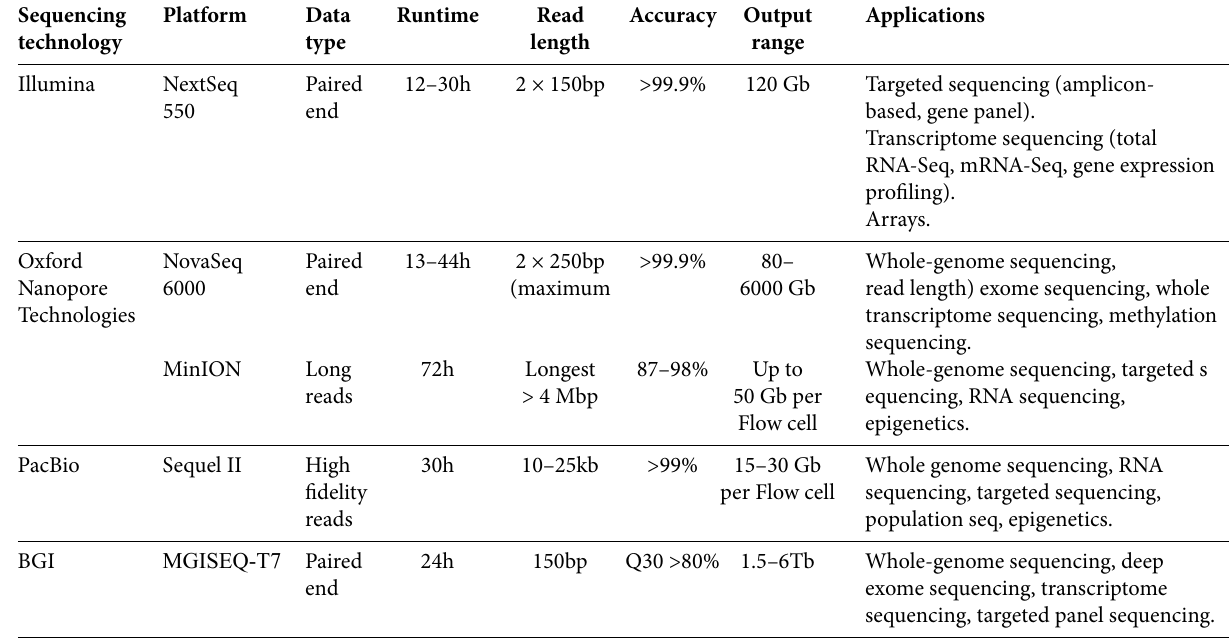
Table 1 : Comparison of next and third generation sequencing